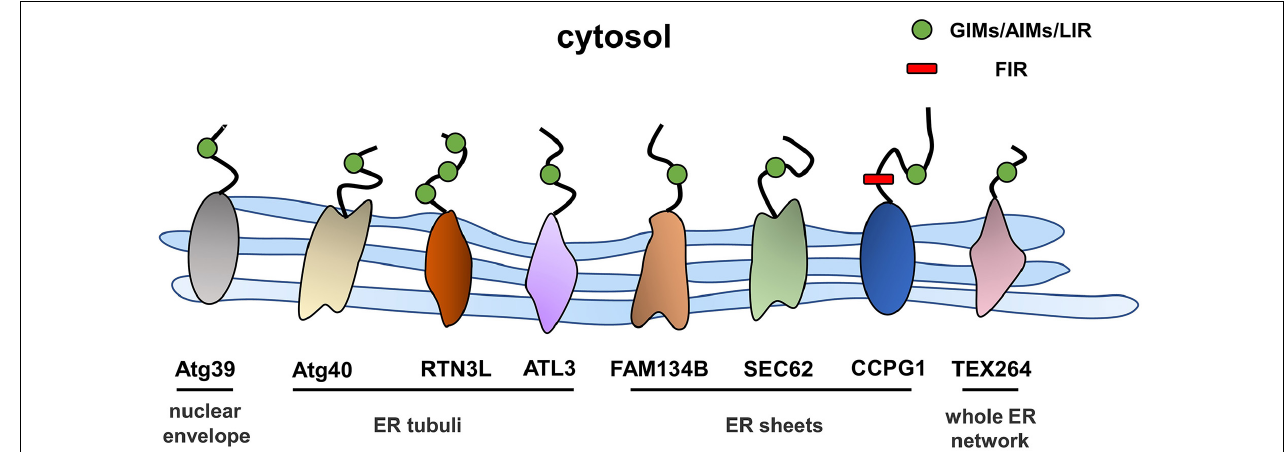
FIGURE 2 | The structures and locations of ER-phagy receptors identified in yeast and